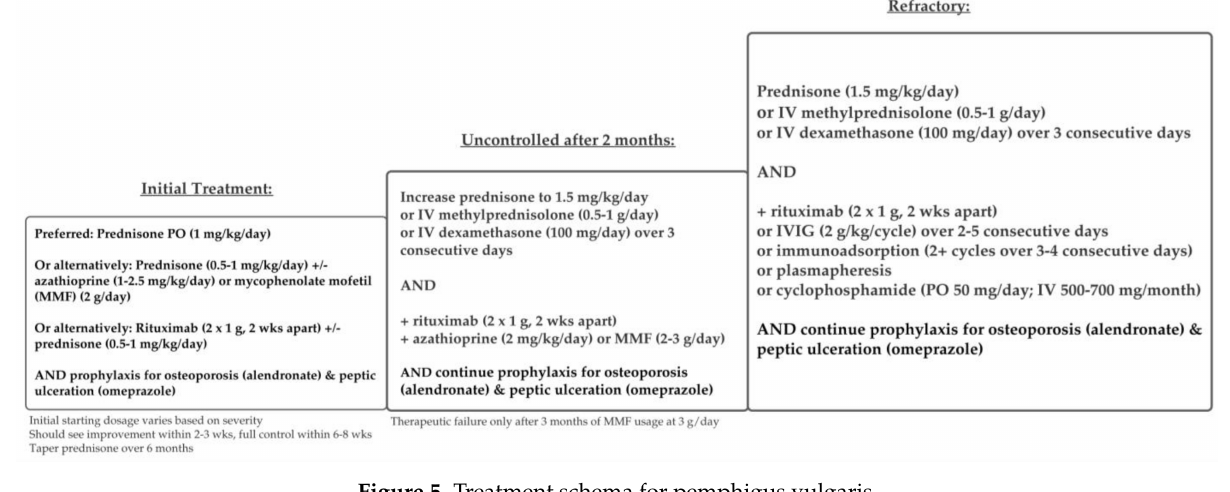
Figure 5. Treatment schema for pemphigus vulgaris.